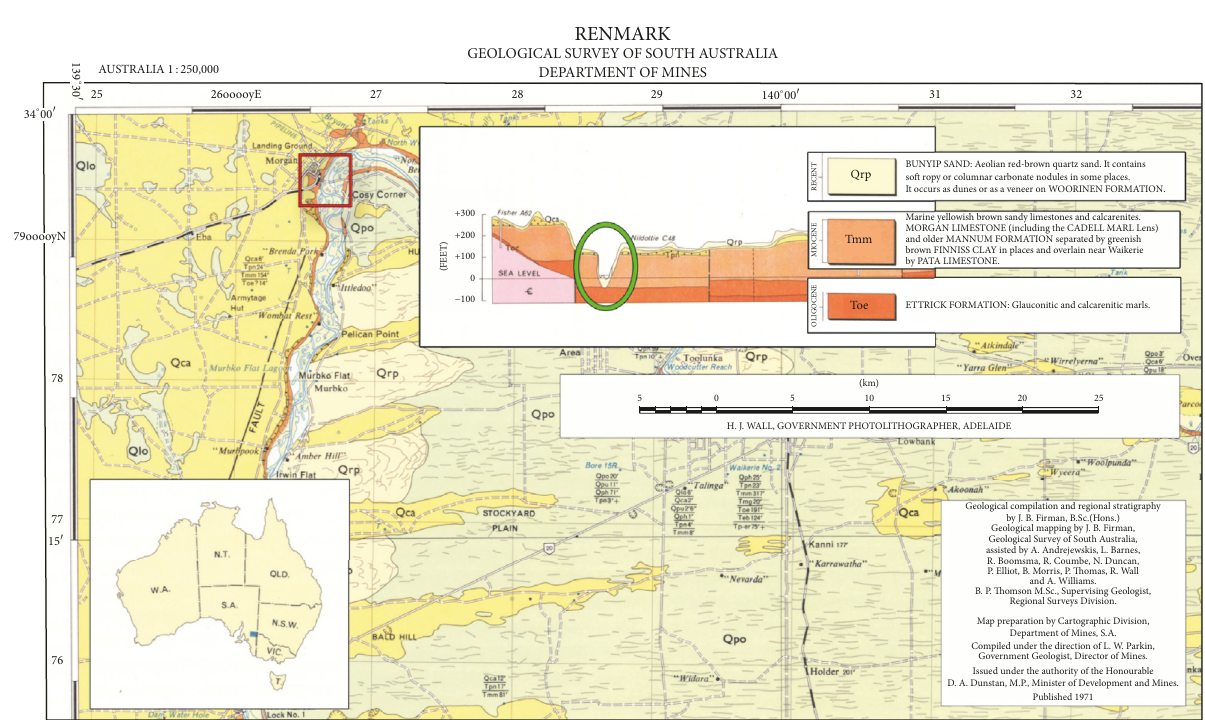
Figure 6: Geological map of the broader survey area (modified from [16]).